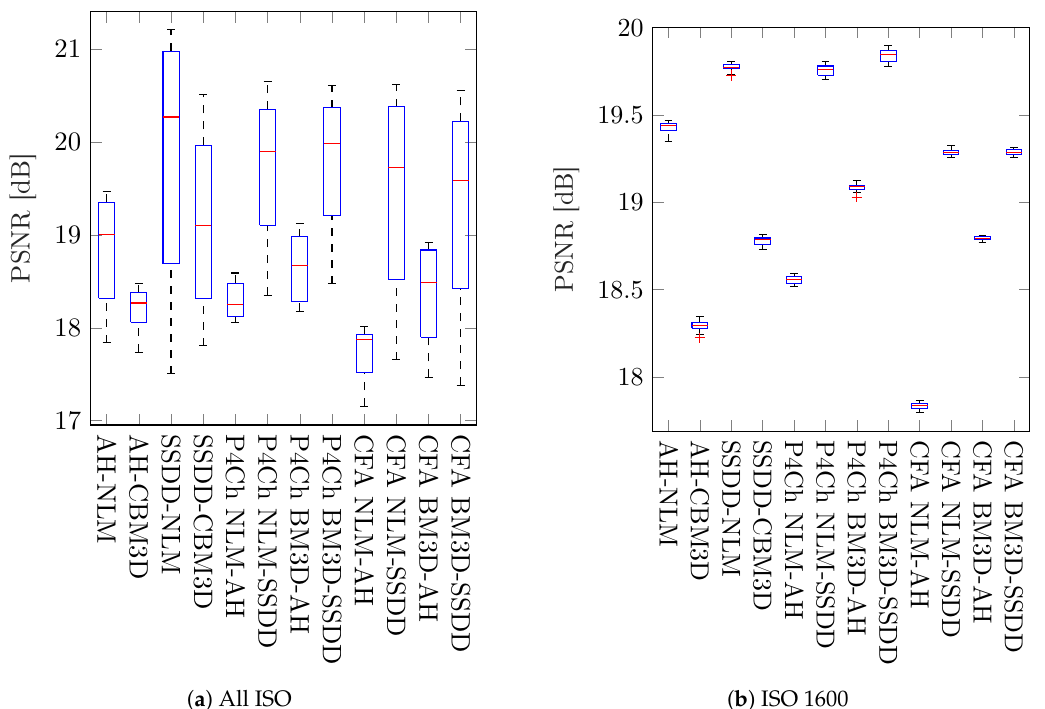
Figure 14. Box plots of PSNR coefficient for the dog test image.